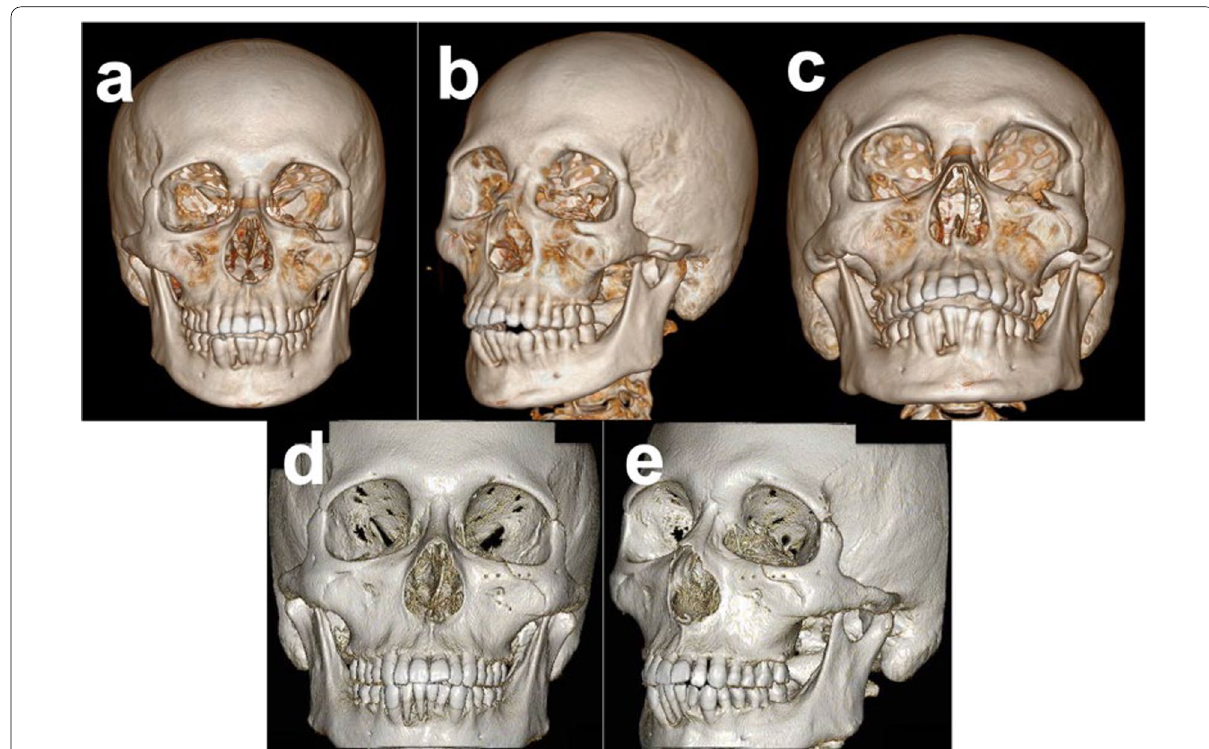
Fig. 2 a Frontal view (fractures of the anterior and posterior walls of the left maxillary sinus, the infraorbital wall, and the frontal zygomatic suture). b Oblique view (The zygomatic arch also broken). c Tilt view (The zygomatic body was deviated laterally downward). d Frontal view 6 months postoperatively (The bones were successfully reduced). e Oblique view 6 months